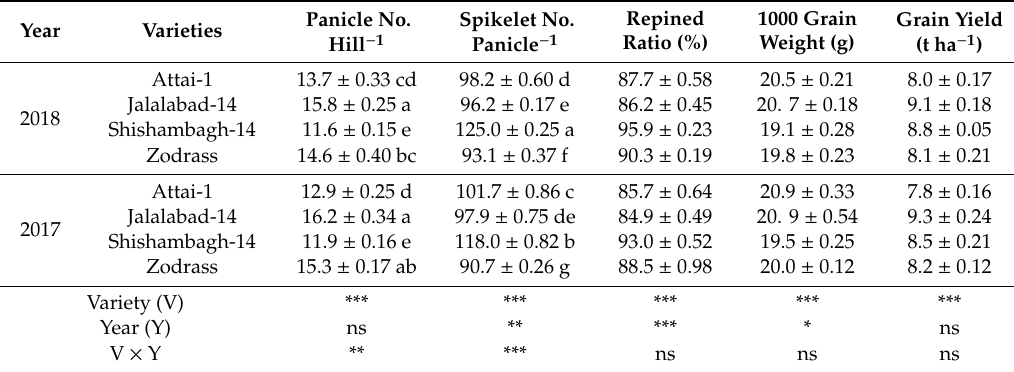
Table 4. Description of grain yield and its components in selected rice